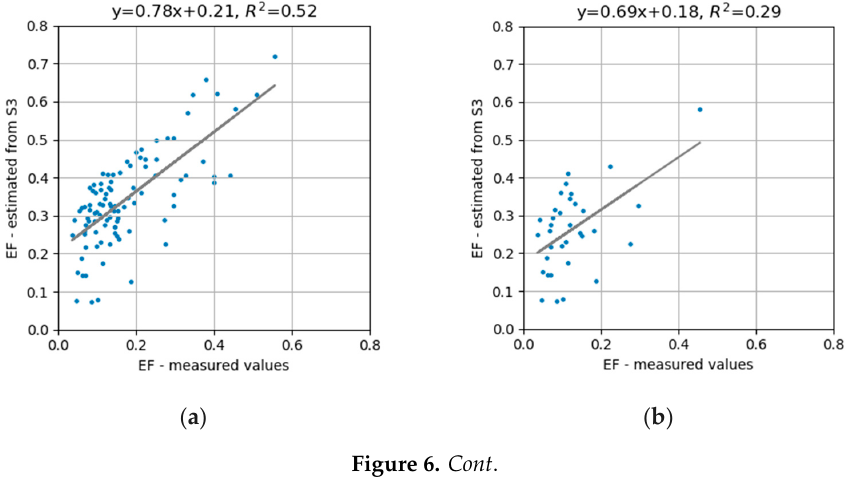
Figure 5. Examples of EF maps (one per month covering the whole period of data analysis from May to September) derived from the “simplified triangle”. The EF maps refer to Sentinel-3 images acquisition dates: ( a ) 16 May, ( b ) 23 June, ( c ) 25 July, ( d ) 5 August, ( e ) 25 August, and ( f ) 25 September.